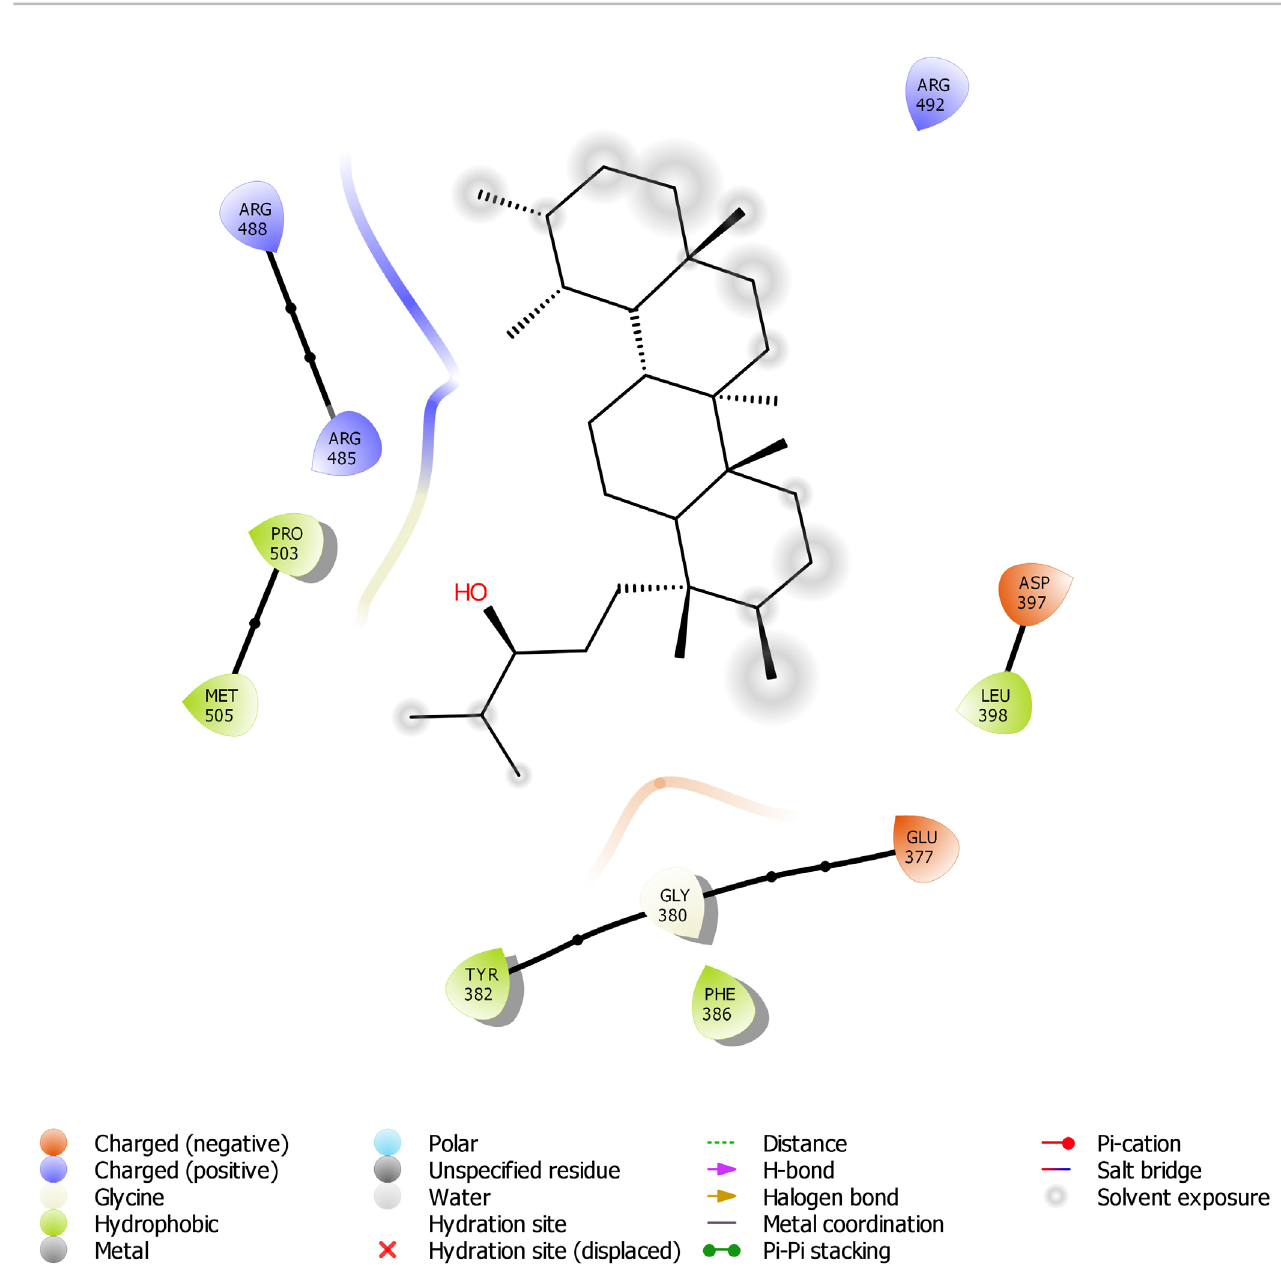
FIGURE 3 - 2D representation of the protein versus ligand interaction (CDC25B and α-amyrin), obtained from Maestro version 12.1.013, with their respective physical-chemical characteristics pointing to the stability of the structure. Such characteristics are crucial for the future development of viable drugs for the treatment of